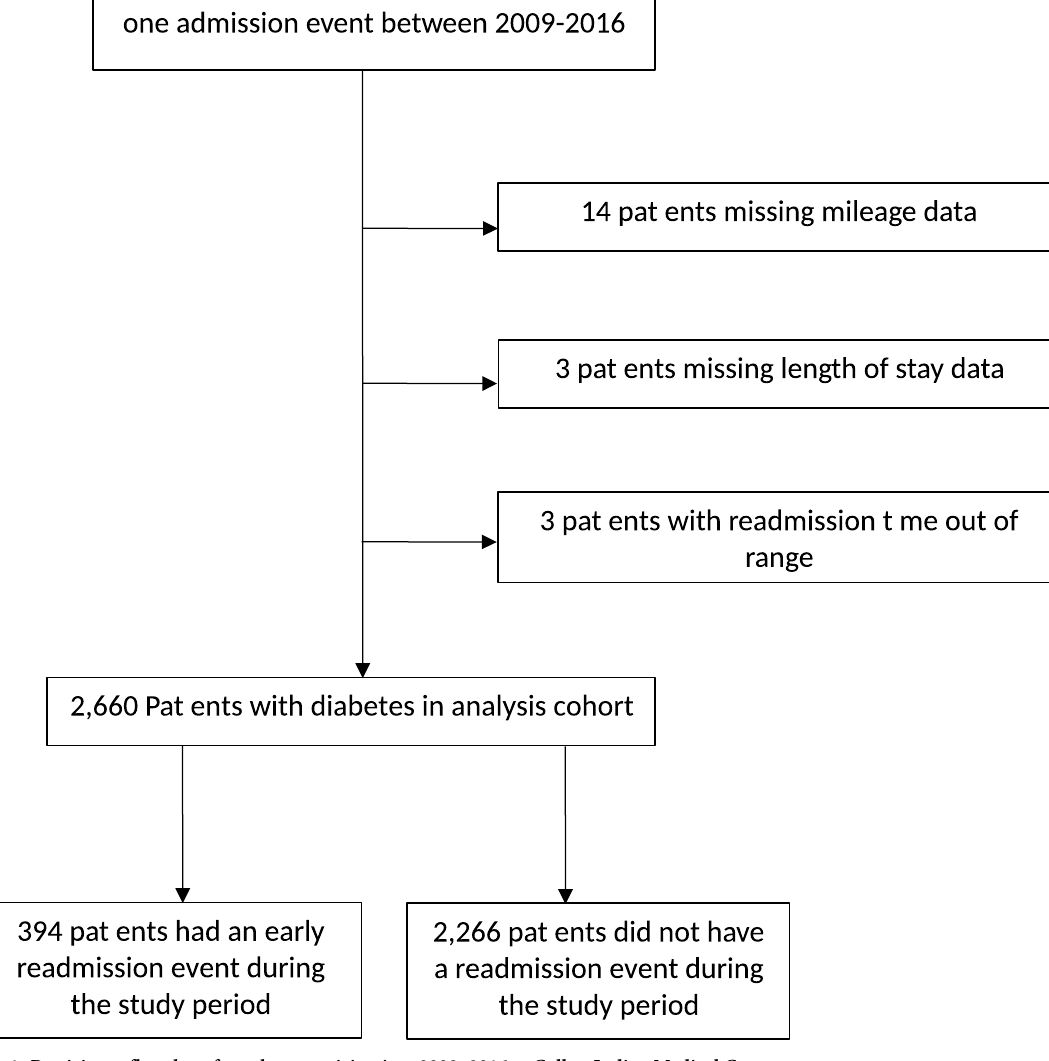
Fig 1. Participant flowchart for cohort participation, 2009–2016 at Gallup Indian Medical